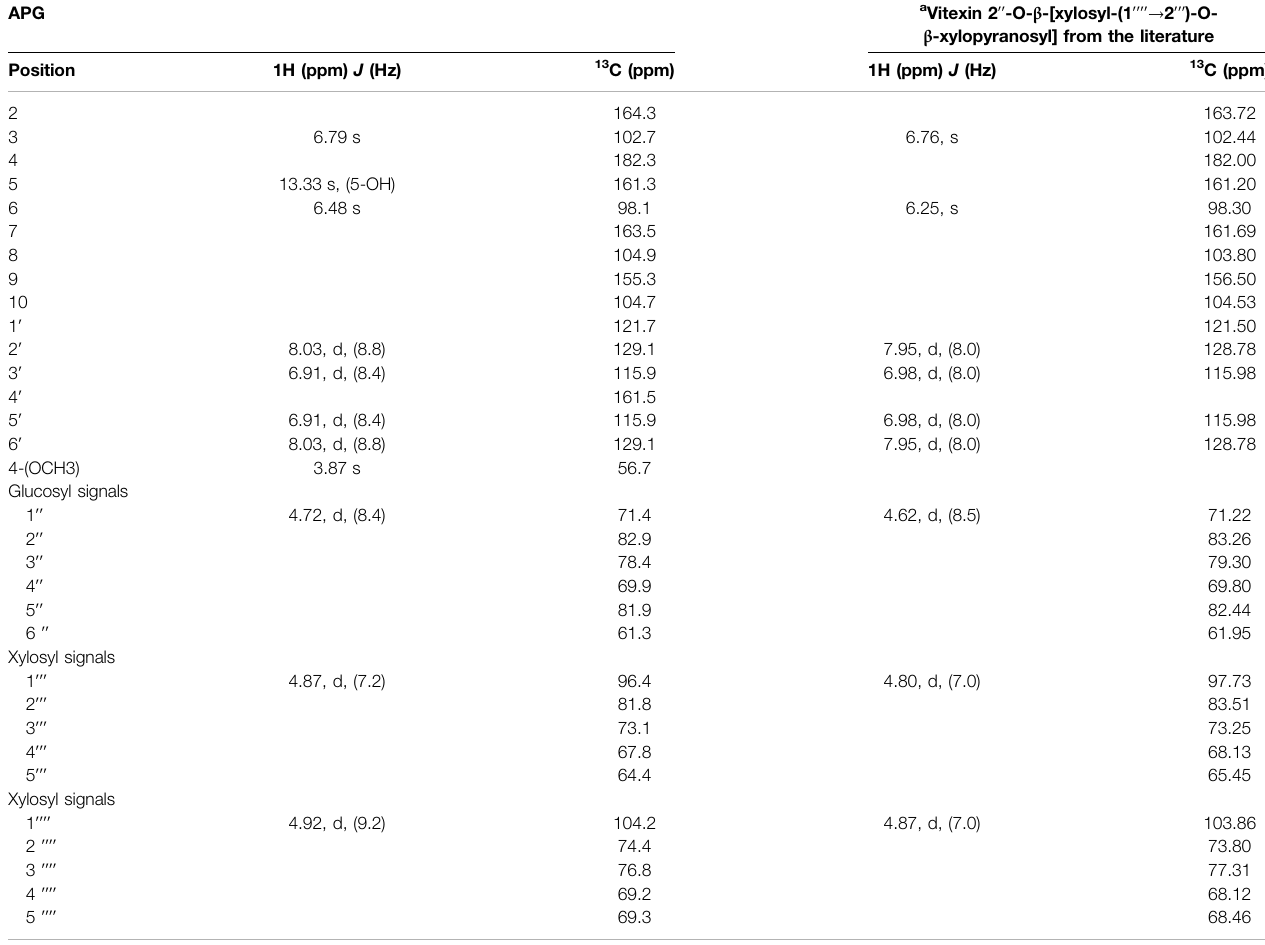
TABLE 1 | 1 H (400 MHz, DMSO- d 6 ) and 13 C (100 MHz, DMSO- d 6 ) NMR data of isolated dye molecule (APG) and vitexin from the literature.